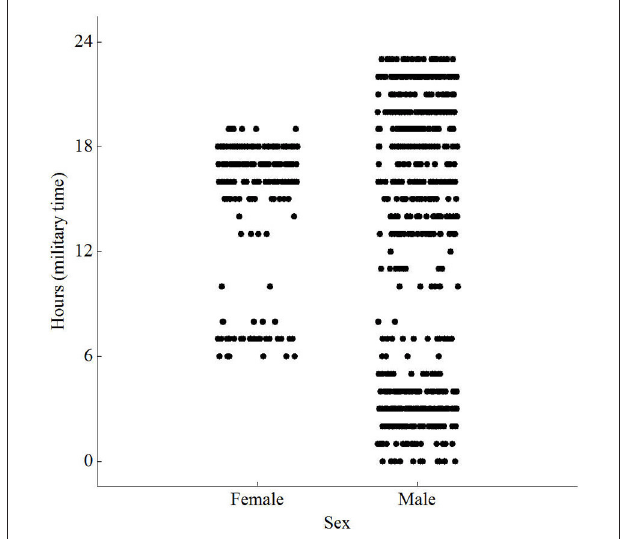
FIGURE 3 | Scatterplot of peak activity by sex and hour [ F (779) = 18.45 ; P < 0.001 ] for wild Norway rats, Rattus norvegicus , captured on Eastern Long Island and monitored from January 14–May